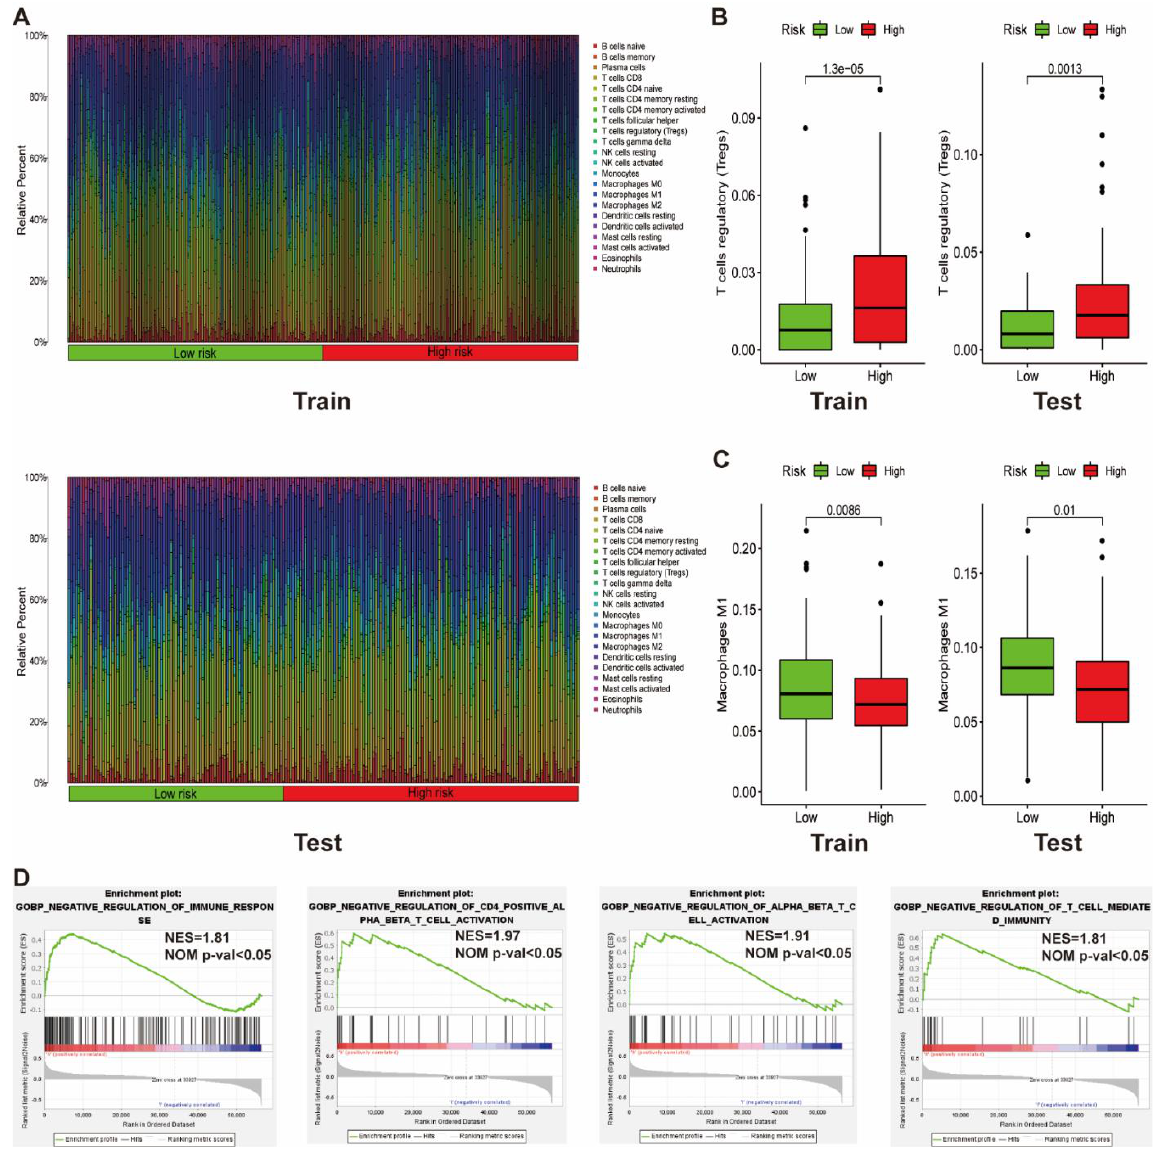
Figure 7. Immune landscape between low and high risk ccRCC patients. ( A ) Relative proportion of immune infiltration in high and low risk patients. ( B , C ) Box plots visualizing significantly different immune cells between high risk and low risk patients. ( D ) GSEA demonstrating that collagen-related signature correlated with immune-related biological function.